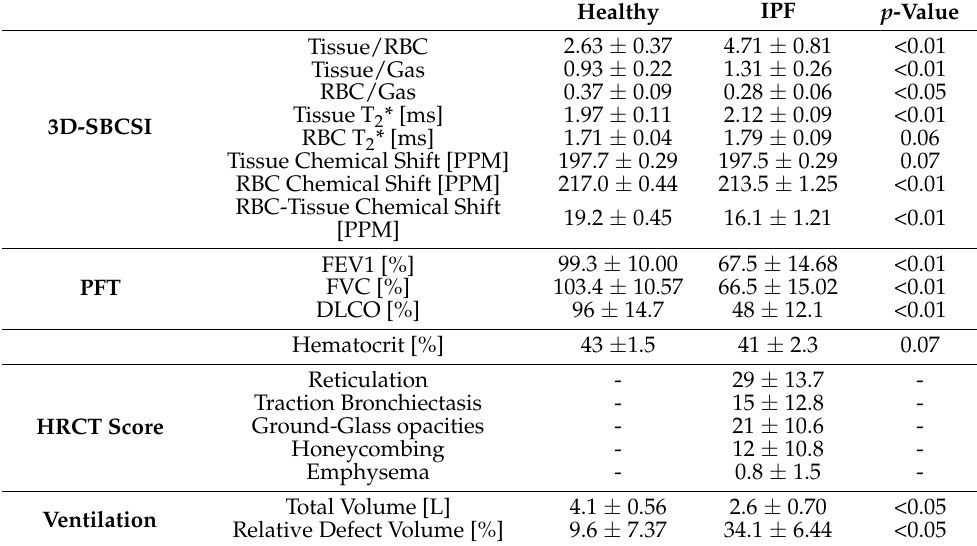
Table 2. Summary of whole lung averages for healthy and IPF